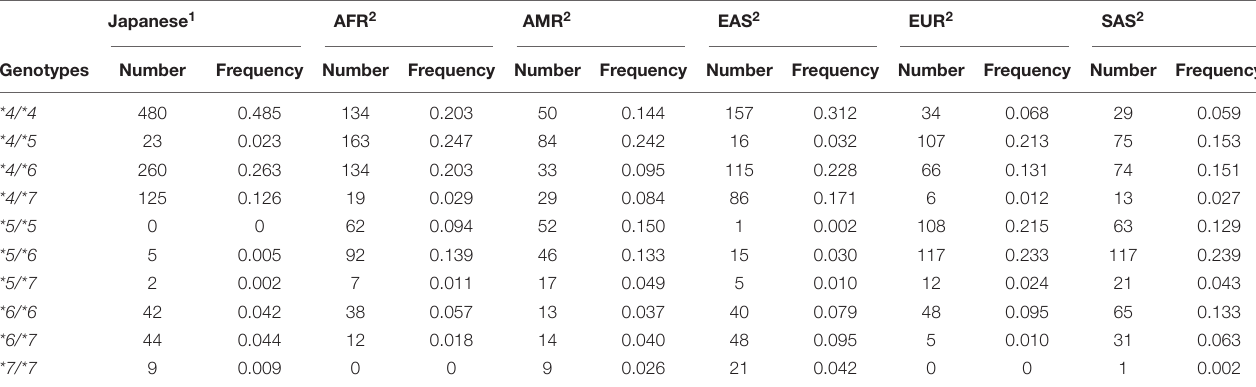
TABLE 1 | Frequency of NAT2 genotypes in 990 Japanese individuals and 2,504 individuals from five populations collected by the 1KGP. Japanese